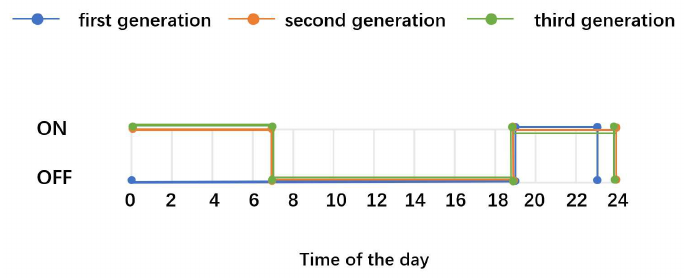
Figure 5. Time schedule of air conditioner being on/off.